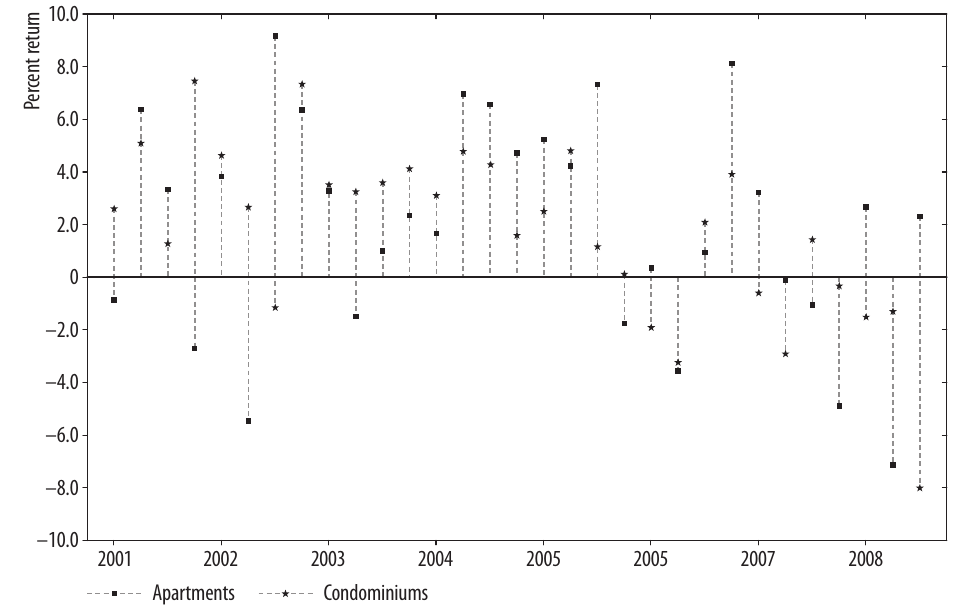
Figure 3. National quarter returns for apartment and condominium complexes. Apartment data from moodys/Real Commercial Property Index. Condominium data from the National Association of